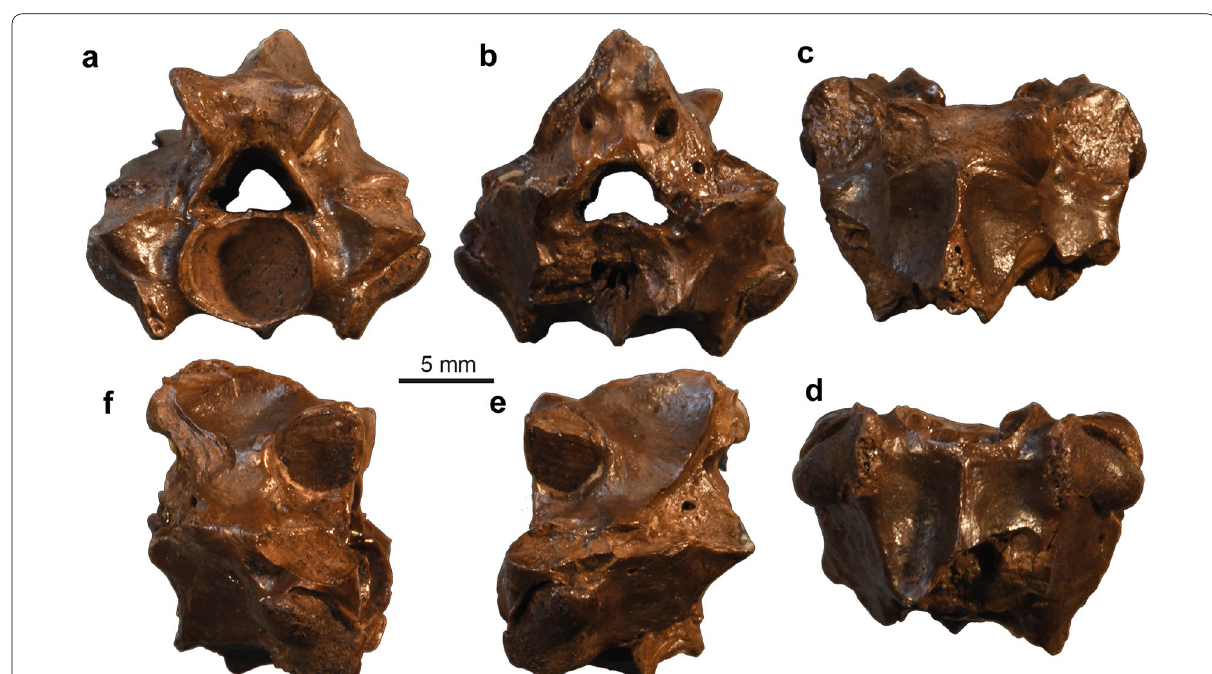
Fig. 18 Palaeopython ceciliensis from quarry Cecilie I, Geiseltal, holotype: mid-trunk vertebra (GMH Ce I-2978-1926) in anterior ( a ), posterior ( b ), dorsal ( c ), ventral ( d ), left lateral ( e ), and right lateral ( f )